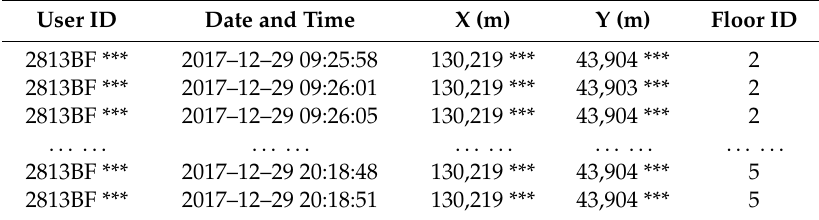
Table 1. Sample table of user trajectory